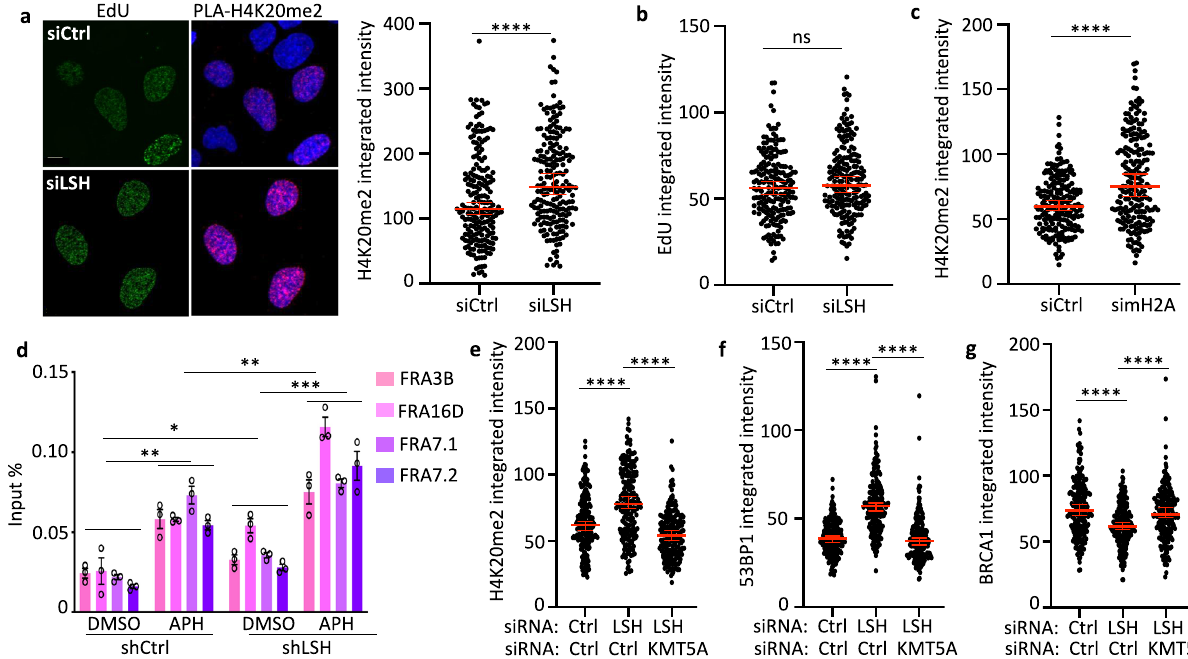
Fig. 8 A role of H4K20 methylation at stalled forks in LSH-de fi cient cells. a Representative images (left panel) and quanti fi cation of PLA signals (H4K20me2: EdU) from U2OS cells transfected with the indicated siRNA (siCtrl or siLSH) after exposure to 4 mM HU for 5 h. The scale bar represents 10 µ m. Quanti fi cation of PLA signals (H4K20me2: EdU) is based on EdU-positive cells. Representative of n = 3 independent experiments. Data